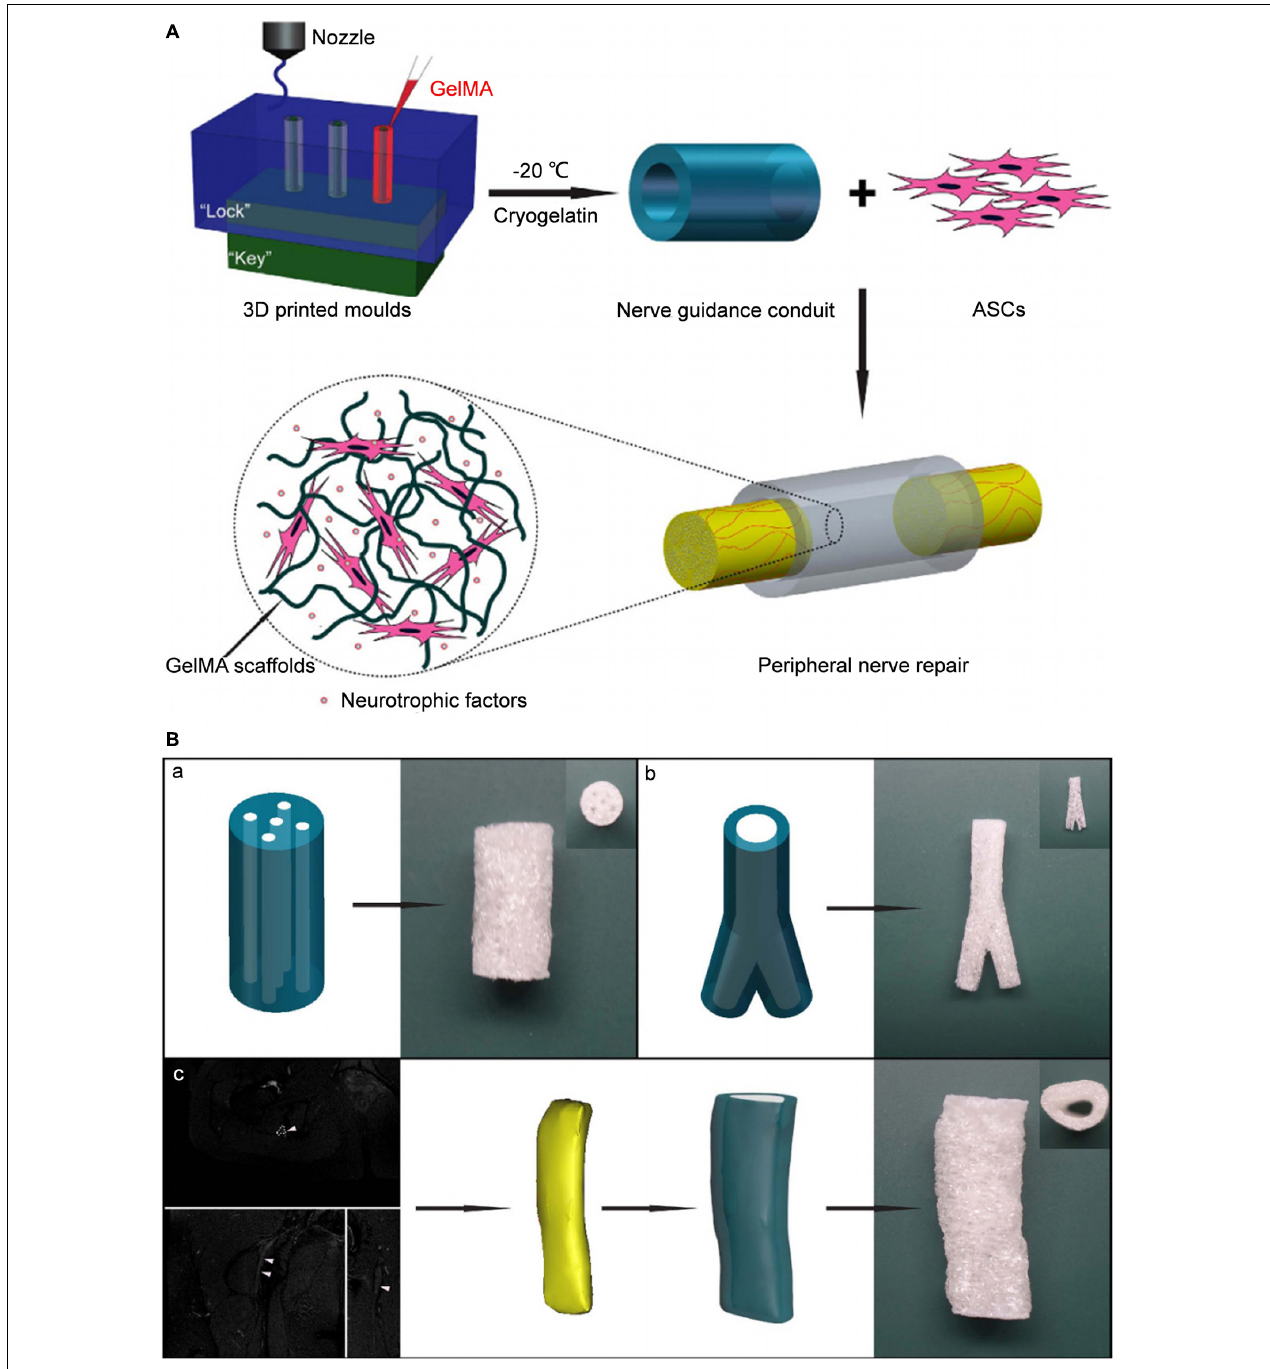
FIGURE 2 | Schematic diagram of tissue engineered NGCs by indirect bioprinting, and computer models and photographs of complex structured NGCs. (A) Schematic diagram of tissue engineered nerve conduits. (B) Computer models and photographs of (a) 4-channel, (b) bifurcating. (c) MRI scan of the human sciatic nerve and the photograph of the corresponding nerve conduit. Reproduced with permission from Hu et al.